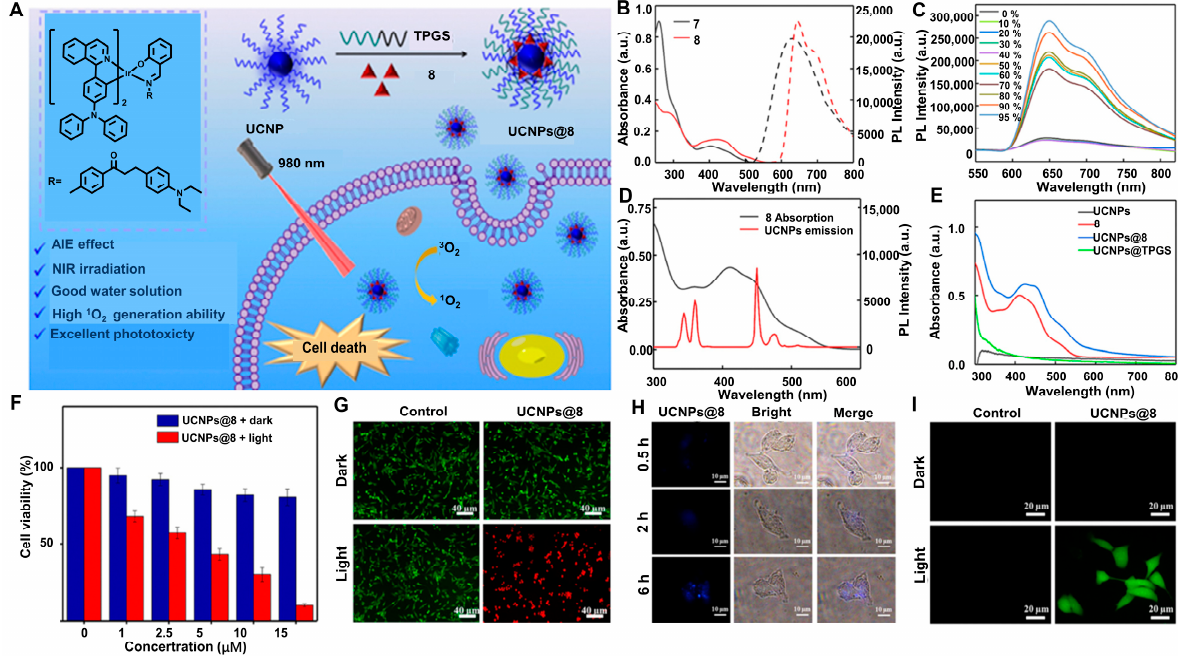
Figure 4. ( A ) Chemical structures of UCNPs@8 and the application PDT. ( B ) Absorption and emission spectra of 7 and 8 . ( C ) PL spectra of 8 in CH 3 CN:H 2 O = 1:9 v / v . ( D ) The UV-vis absorption spectra of 8 (black line) and the PL spectra of UCNPs (red line). ( E ) The UV-vis absorption spectra of 8 , UCNPs, fluorescence images of 4T1 cells co-stained with calcein-AM (live cells, green fluorescence)